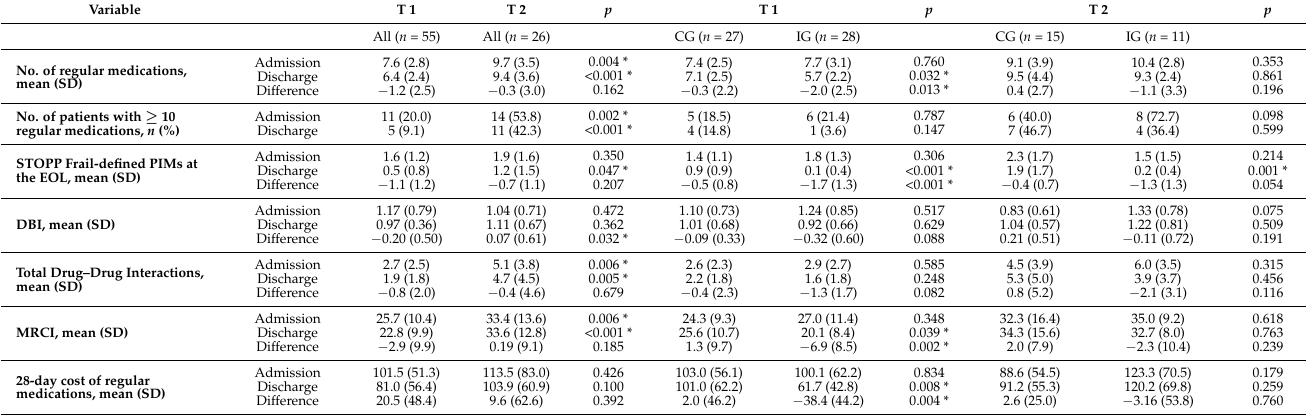
Table 3. Admission and discharge review analysis according to illness